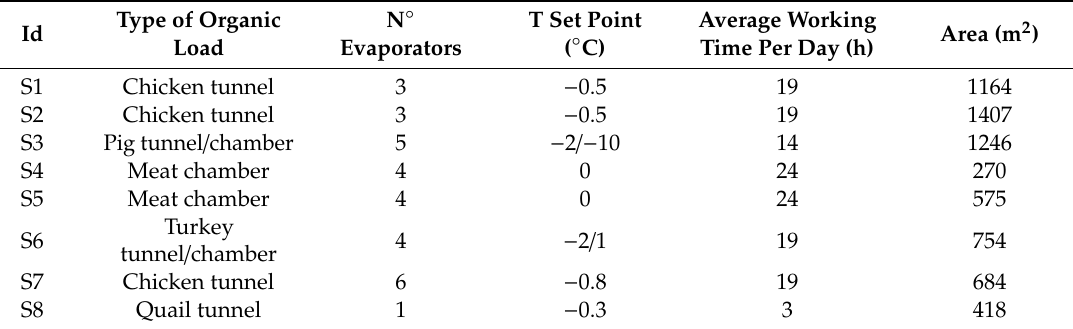
Table 1. Characteristics of each space to refrigerate.